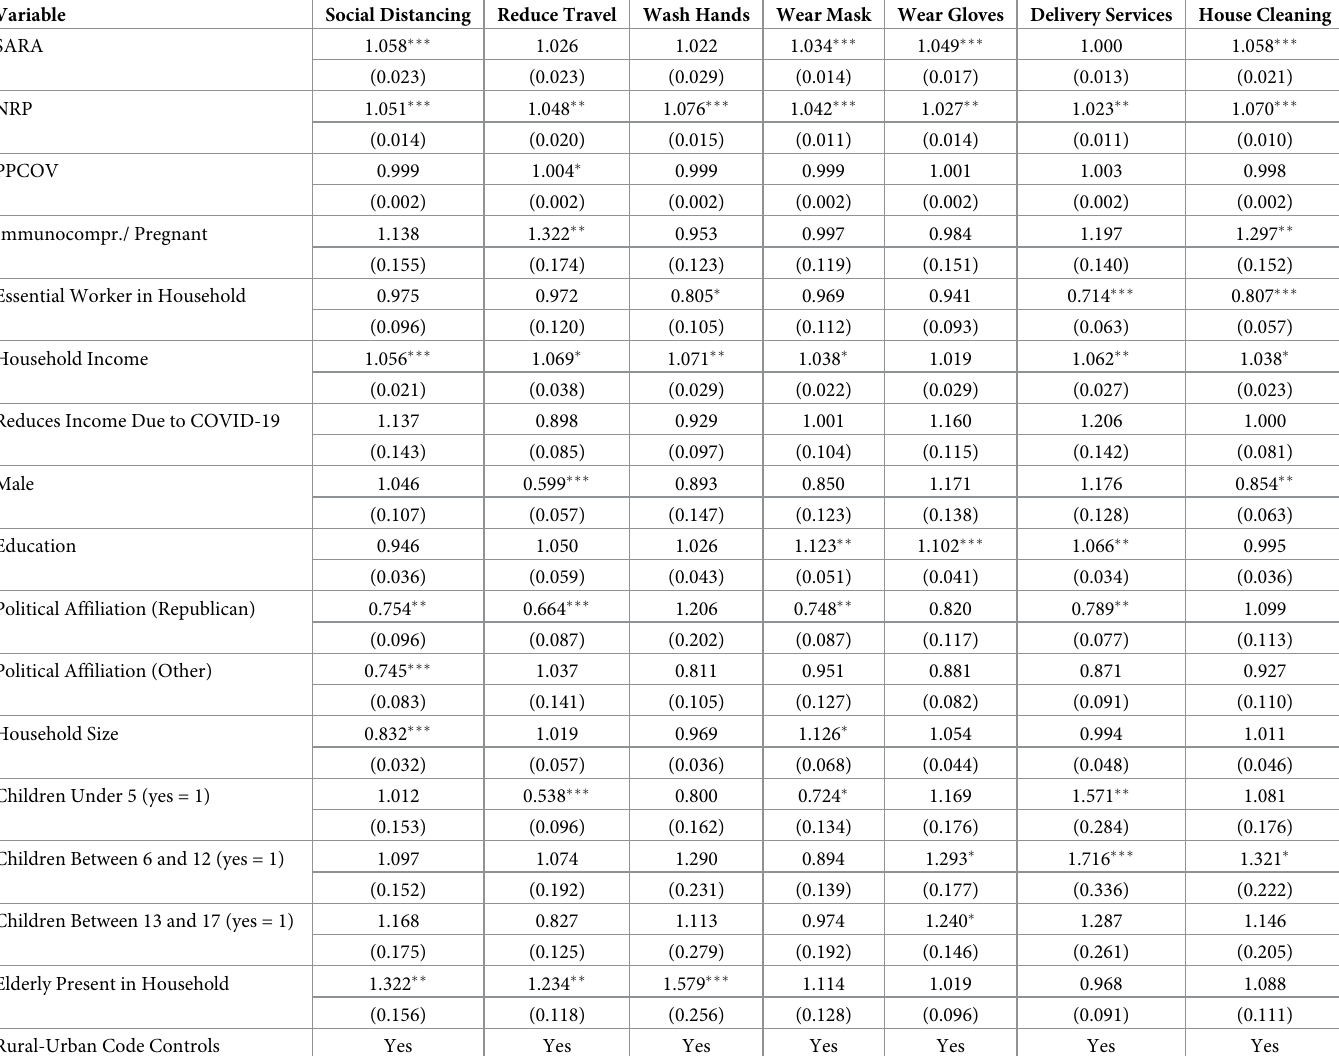
Table 4. Odds ratios for factors correlated with the likelihood of adopting mitigation